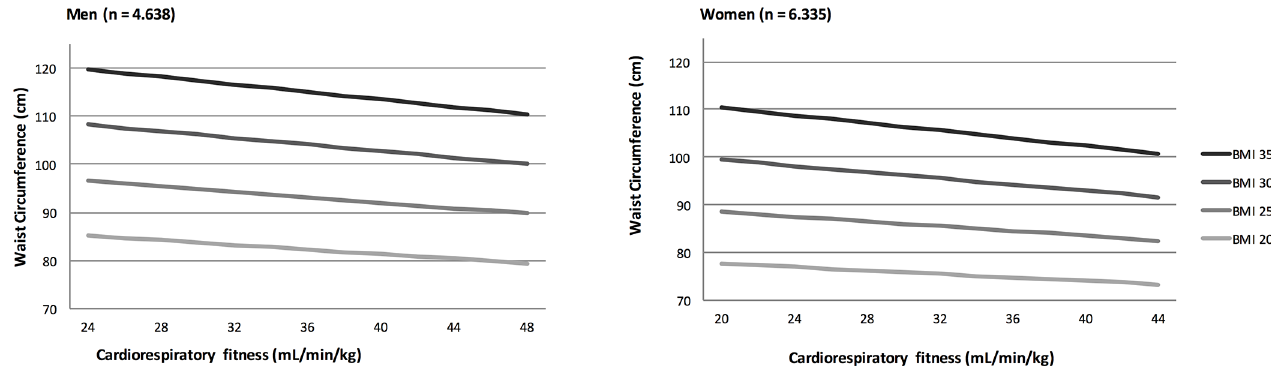
Fig 2. Waist circumference by cardiorespiratoryfitness and BMI in men and women. Valuesare estimated, from the regressionmodel, for a 40 year old woman or man with a BMI (kg/m 2 ) of respectively20, 25, 30 or 35.